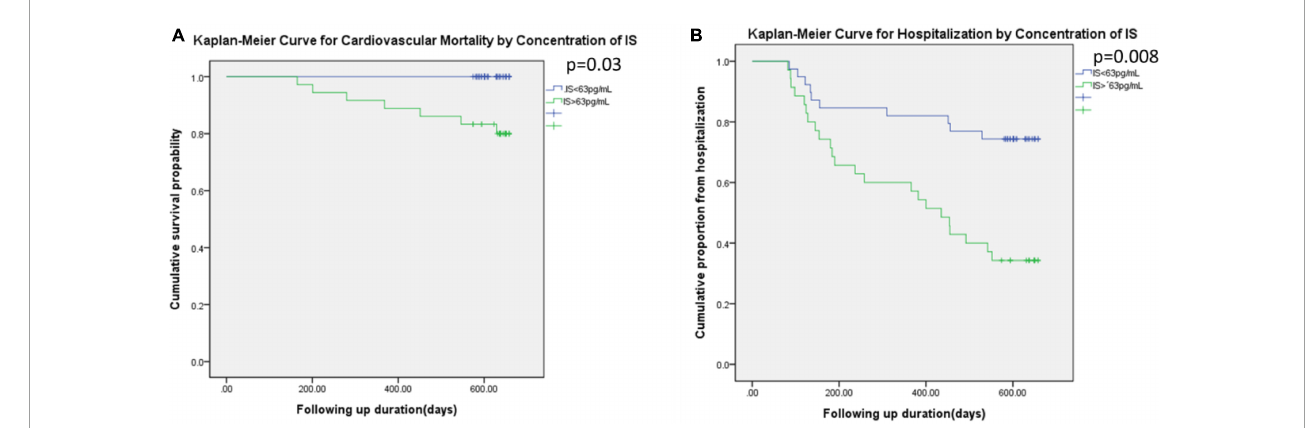
FIGURE4 Kaplan–Meier curve for the cardiovascular mortality (A) and the hospitalization (B) based on the IS level (higher than 63 pg/ml or